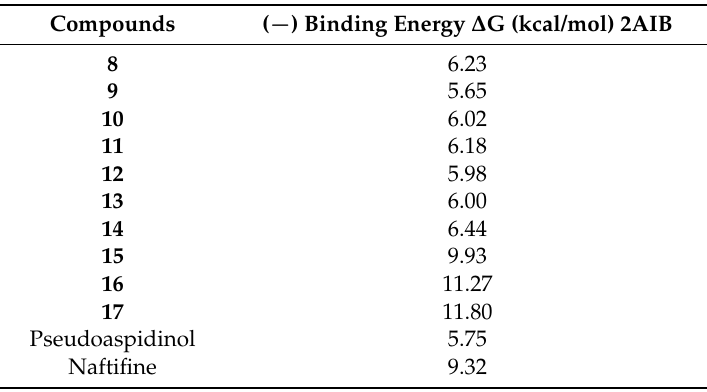
Figure 6. Plots of RMSD for all of the backbone atoms (Å) vs. simulation time (ps) for 2AIB in complex with compound 17 . Table 2. Docking results of synthesized